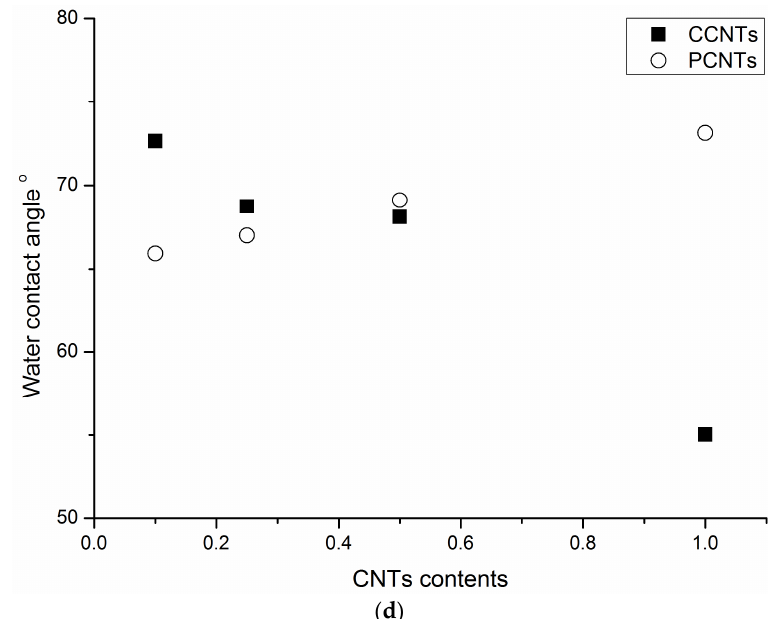
Figure 1. XRD characterization of PCNT and CCNT ( a ), TEM images of CCNT ( b ) and PCNT ( c ), and Water contact angle of PS/CNTs nanocomposite membranes as a function of CNTs content ( d ).